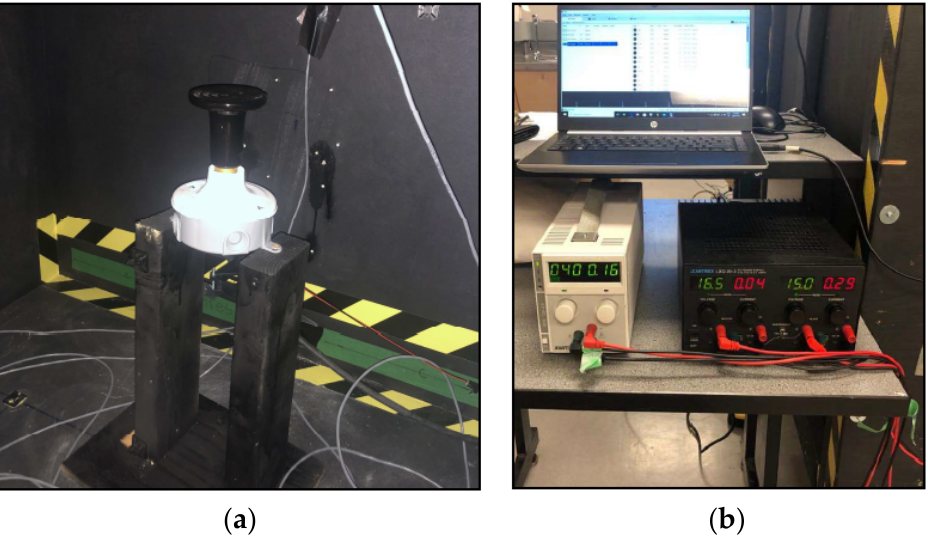
Figure 3. ( a ) Ceramic heat bulb; ( b ) DC power supply